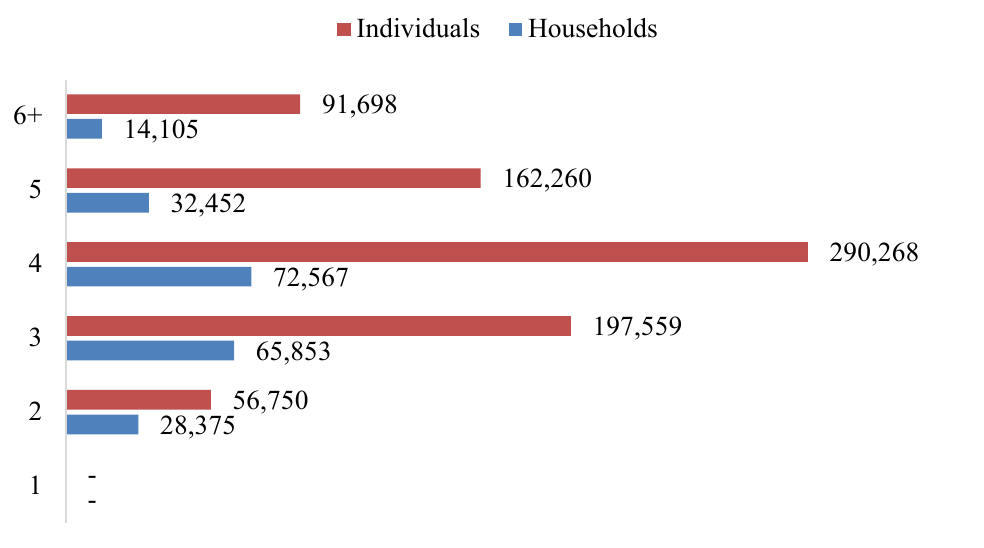
Figure 18. REM recipients, by household composition, 2021. Source: own elaboration on the INPS database.